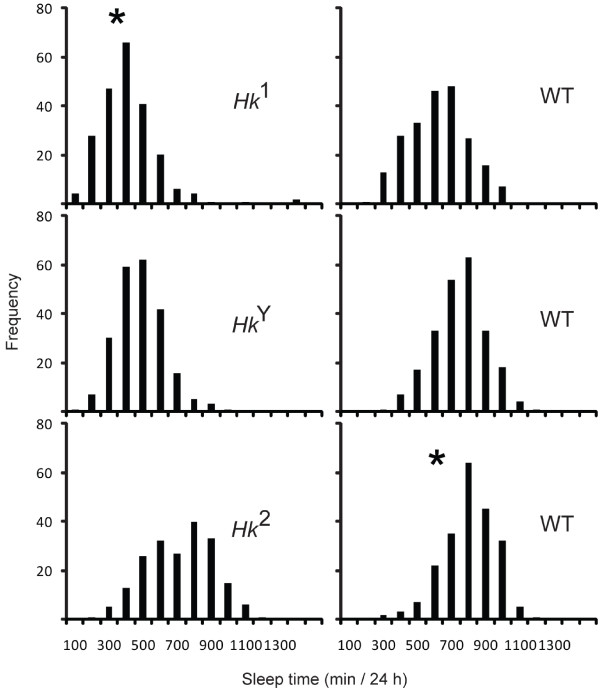
Interindividual variability in daily sleep amount. Mean values of daily sleep amount (min/24 h) from day 1 to day 28 per each fly (same flies as in Fig. 1). * indicates lines in which the null hypothesis (normal distribution) was rejected (p < 0.05, Lilliefors test of normality).